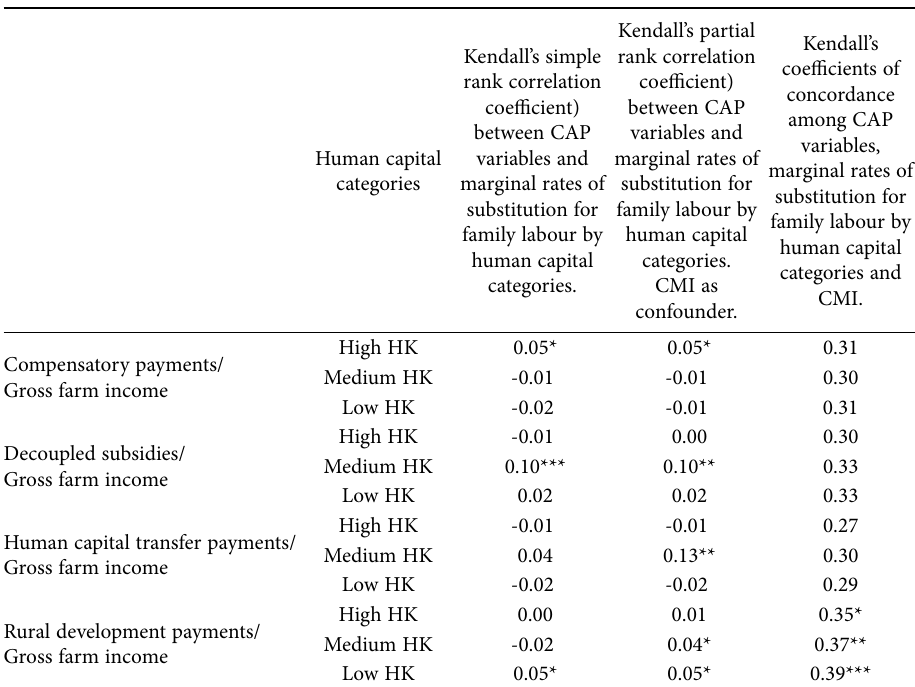
Table 7. Kendall’s